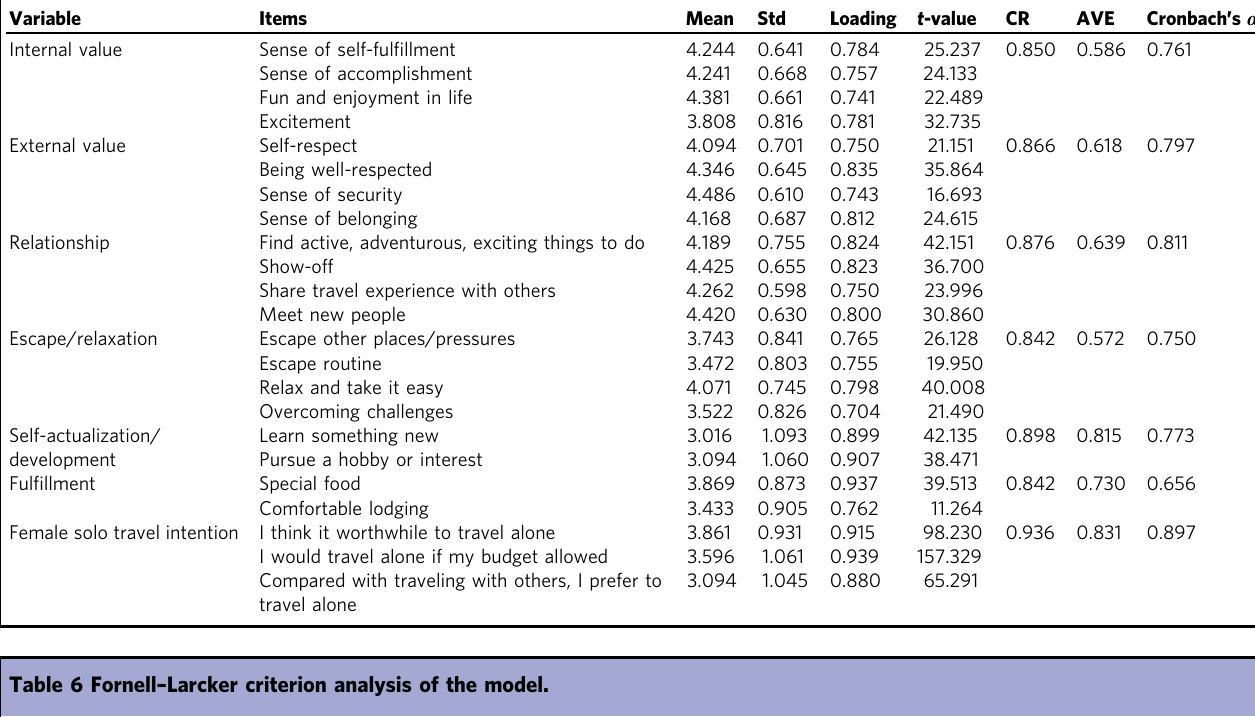
Table 5 Con fi rmatory factor analysis (CFA).